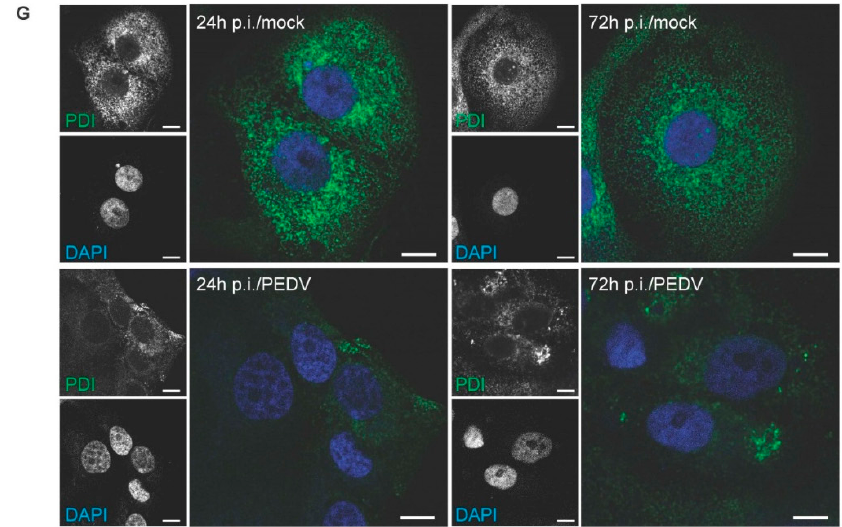
Figure 5. PEDV infection causes different ER membrane rearrangements. Vero E6 cells infected with PEDV were collected at different p.i. timepoints as described in the Materials and Methods section, before being processed for conventional EM ( A – C ), immuno- EM ( D , E ), and immunofluorescence ( F ). ( A ) ER observed at 0 h p.i., which typically appears as long dispersed tubular structures, with many ribosomes sitting on the limiting membrane; ( B ) representative morphology of proliferating ER in PEDV-infected cells, showing an arrangement of 5–10 layers of tubular rough ER; ( C ) the percentage of cell sections in the experiment shown in Figure 1 that displays ER proliferation, DMVs, CMs, virion-positive ER, and ERBs; ( D ) the ER surface area at each p.i. timepoint was determined using the point-hit method. The data are presented relative to the 0 h p.i. control; ( E ) morphology of the ER in non-infected cells labeled with an anti-KDEL antibody; ( F ) representative images of ERBs labeled with the anti-KDEL antibody; ( G ) the subcellular distribution of PDI (green), an ER protein marker, was examined by immunofluorescence with or without PEDV infection at 24 and 72 h p.i. Nuclei were stained with DAPI (blue). Representative immunofluorescence images were from three independent experiments. Error bars represent the standard deviation from three grids. M: mitochondrion; N: nucleus; PM: plasma membrane; ER: endoplasmic reticulum. Black scale bar, 500 nm; white scale bar, 10 μ m.